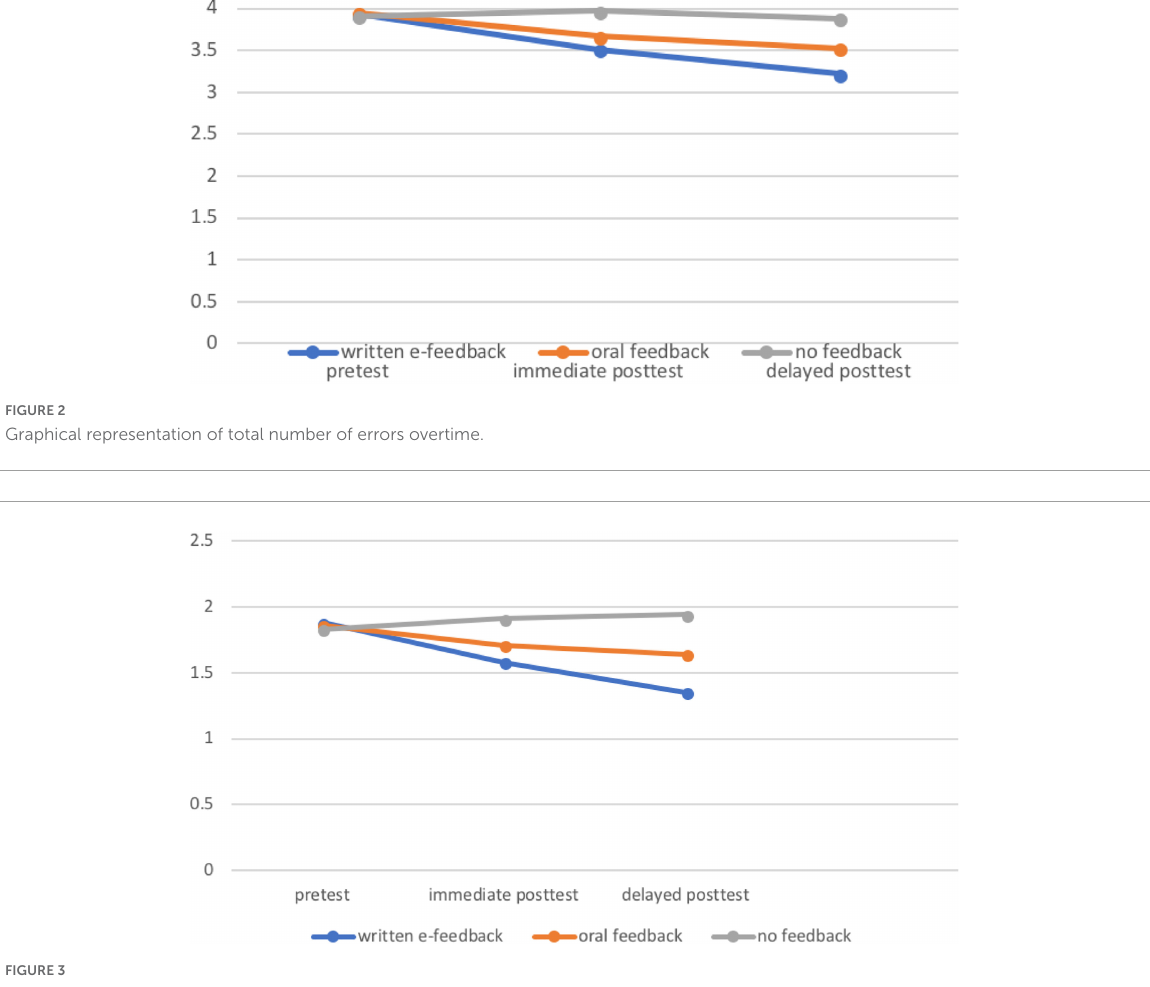
FIGURE3 Graphical representation of number of conjunction errors